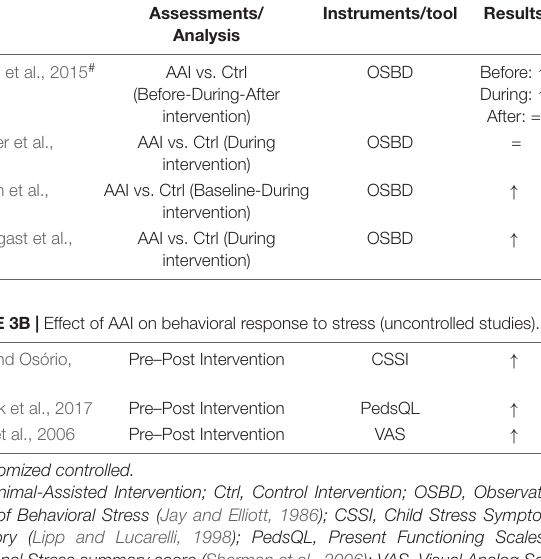
TABLE 3A | Effect of AAI on behavioural response to stress (controlled studies).